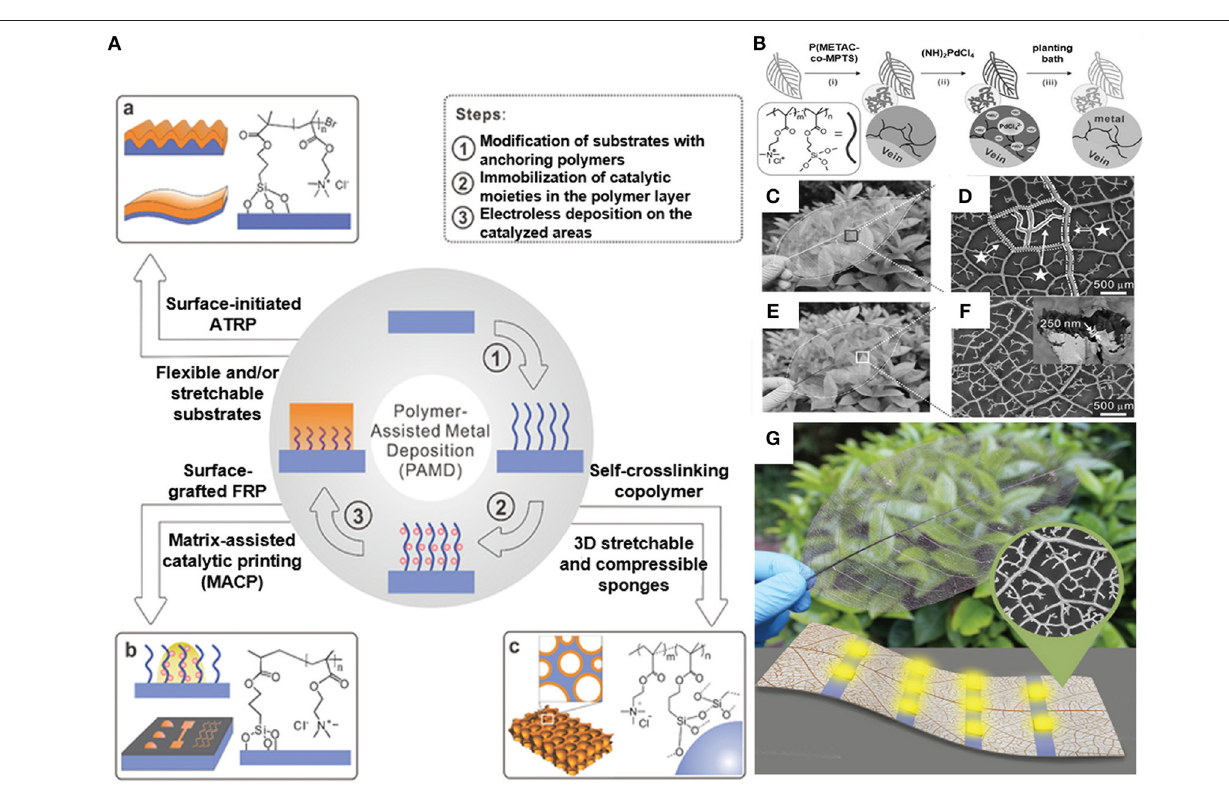
Frontiers in Materials |